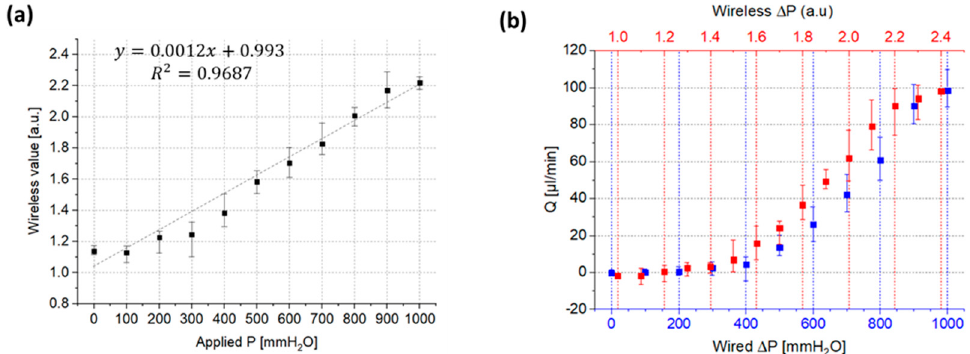
Figure 6. The calibrated wireless pressure sensor was used for valve functional tests in the positive pressure range and served to provide reasonable hydrodynamic behavior of the valve. ( a ) Calibra- tion of the wireless sensor in terms of the applied pressure. ( b ) Flow response of the valve in the wired / wireless measurement. The valve demonstrated reasonable flow response in both modes with high flow diodicity and no flow leakage. By the wired measurement, the valve shows flow rates of 0~98.5 μ L/min, P T of 113.0 ± 9.8 mmH 2 O, and negligible reverse flow leakage of 3.7 μ L/min. The wireless measurement also displays that the valve has a comparable flow response to the wired measurement with a P T of 108.1 ± 3.4 mmH 2